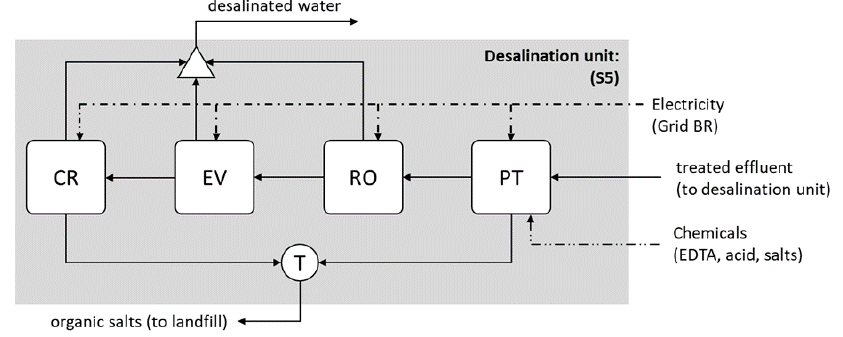
Figure 2. Detail of the desalination system for scenario S5.